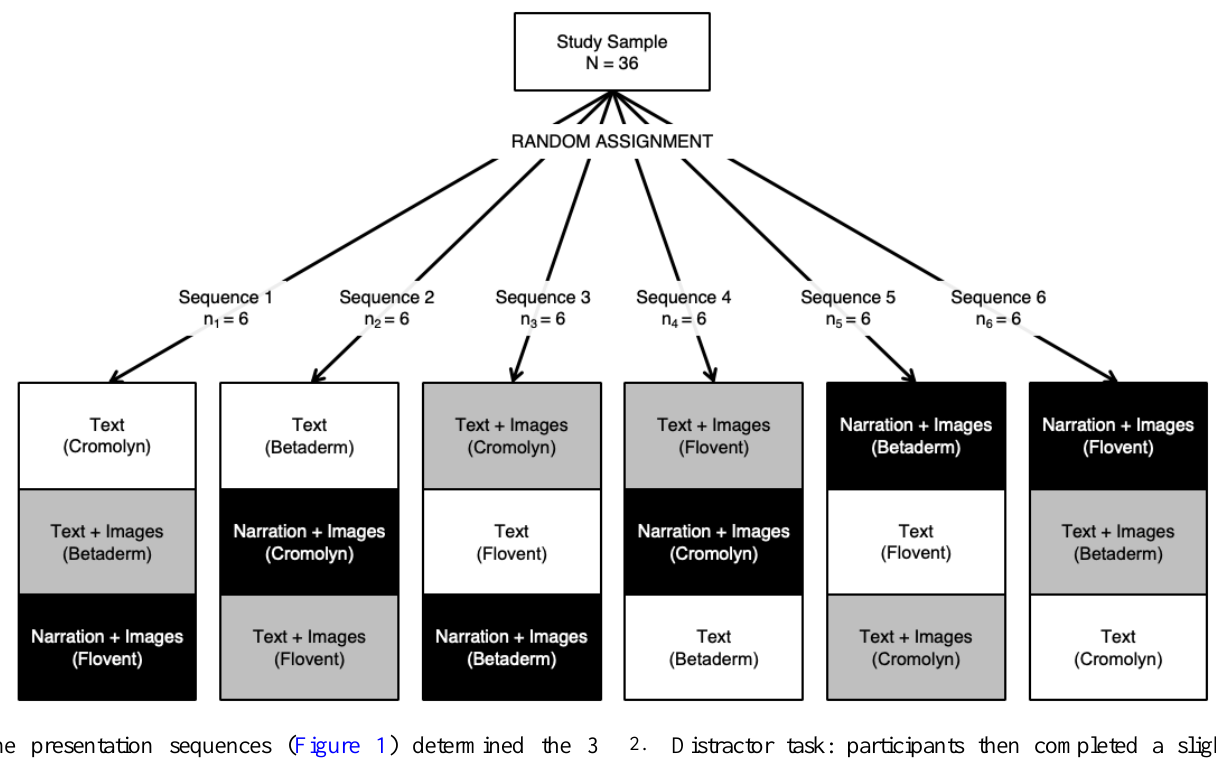
Figure 1. Experimental design: randomized and counterbalanced for format and medication (in